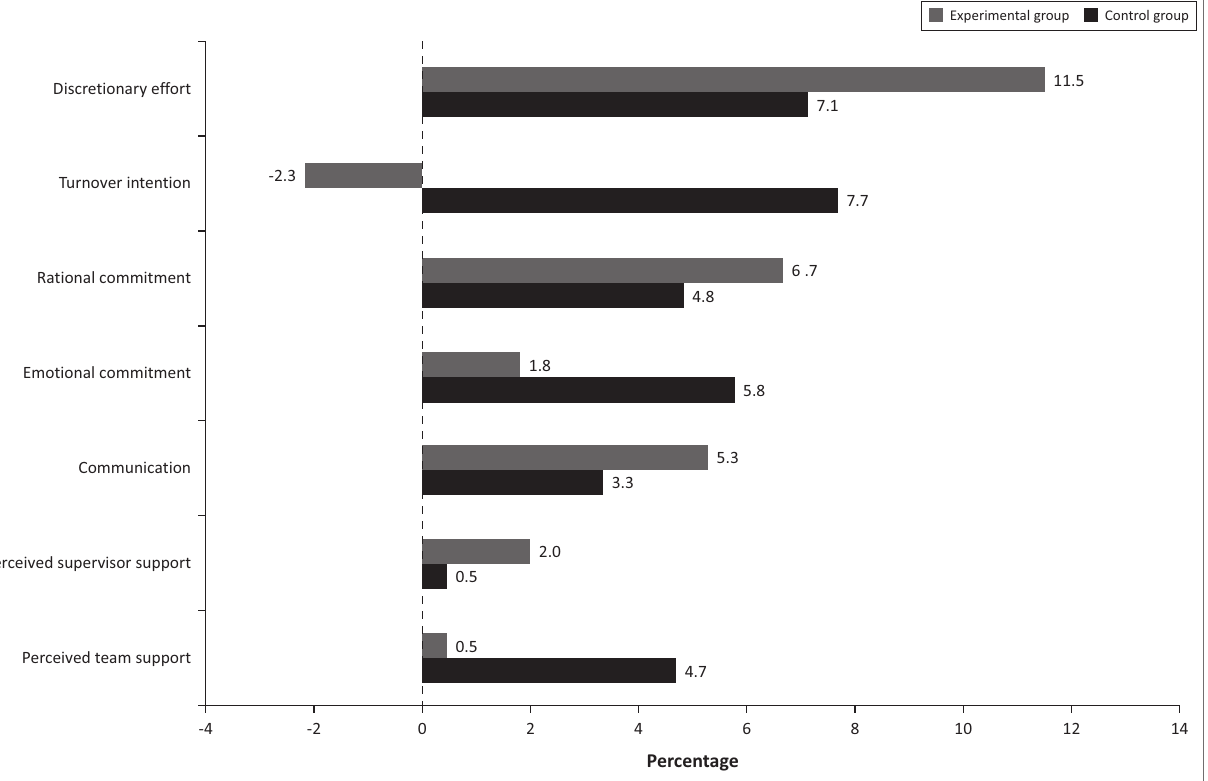
FIGURE 2: Extent of differences between experimental group and control group over two years.